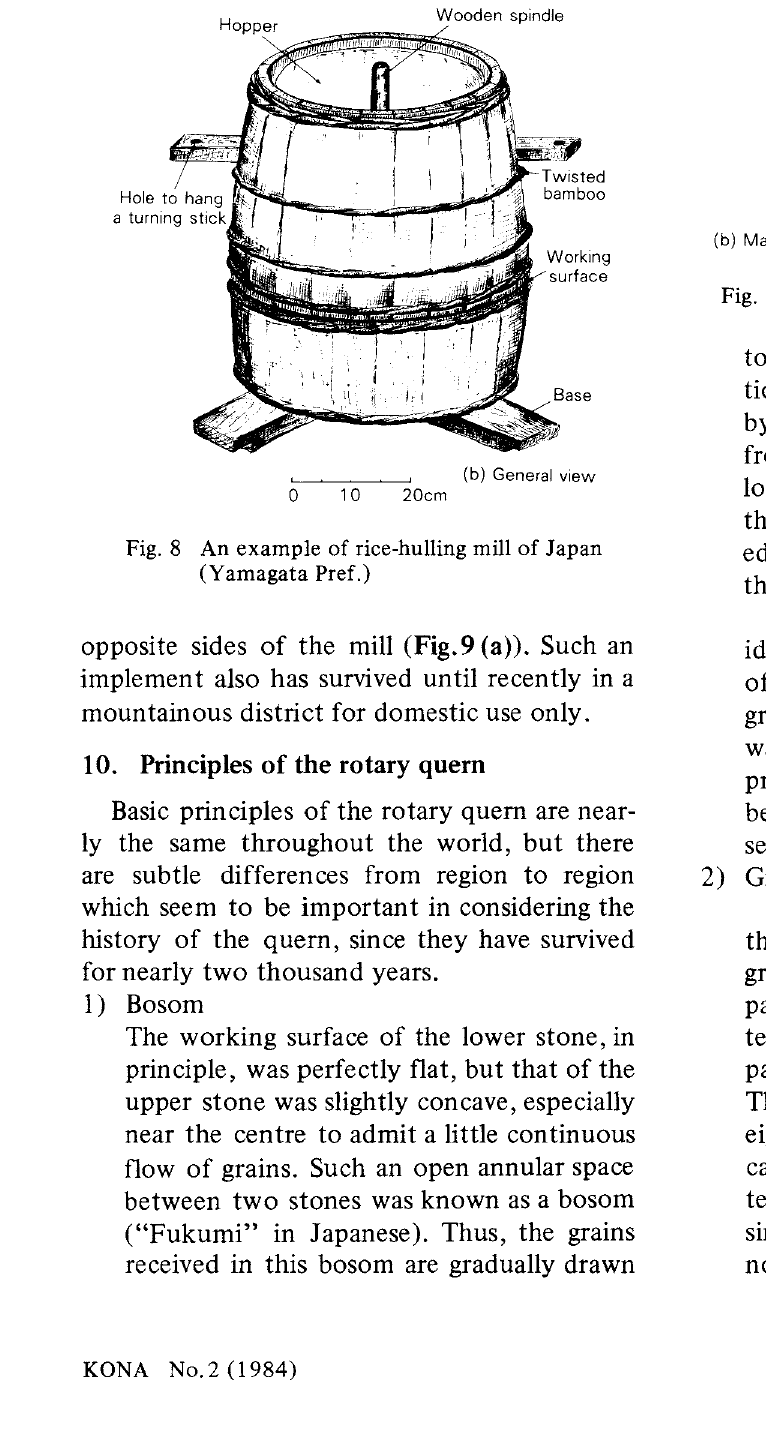
Fig. 9 Principles of operation of a rice-hulling